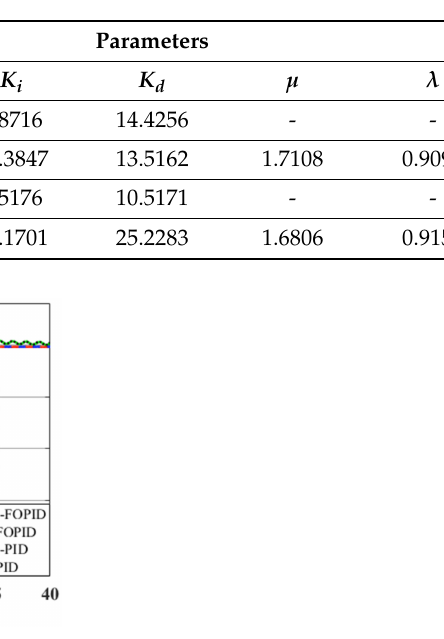
Table 4. Optimal parameters of the controller.